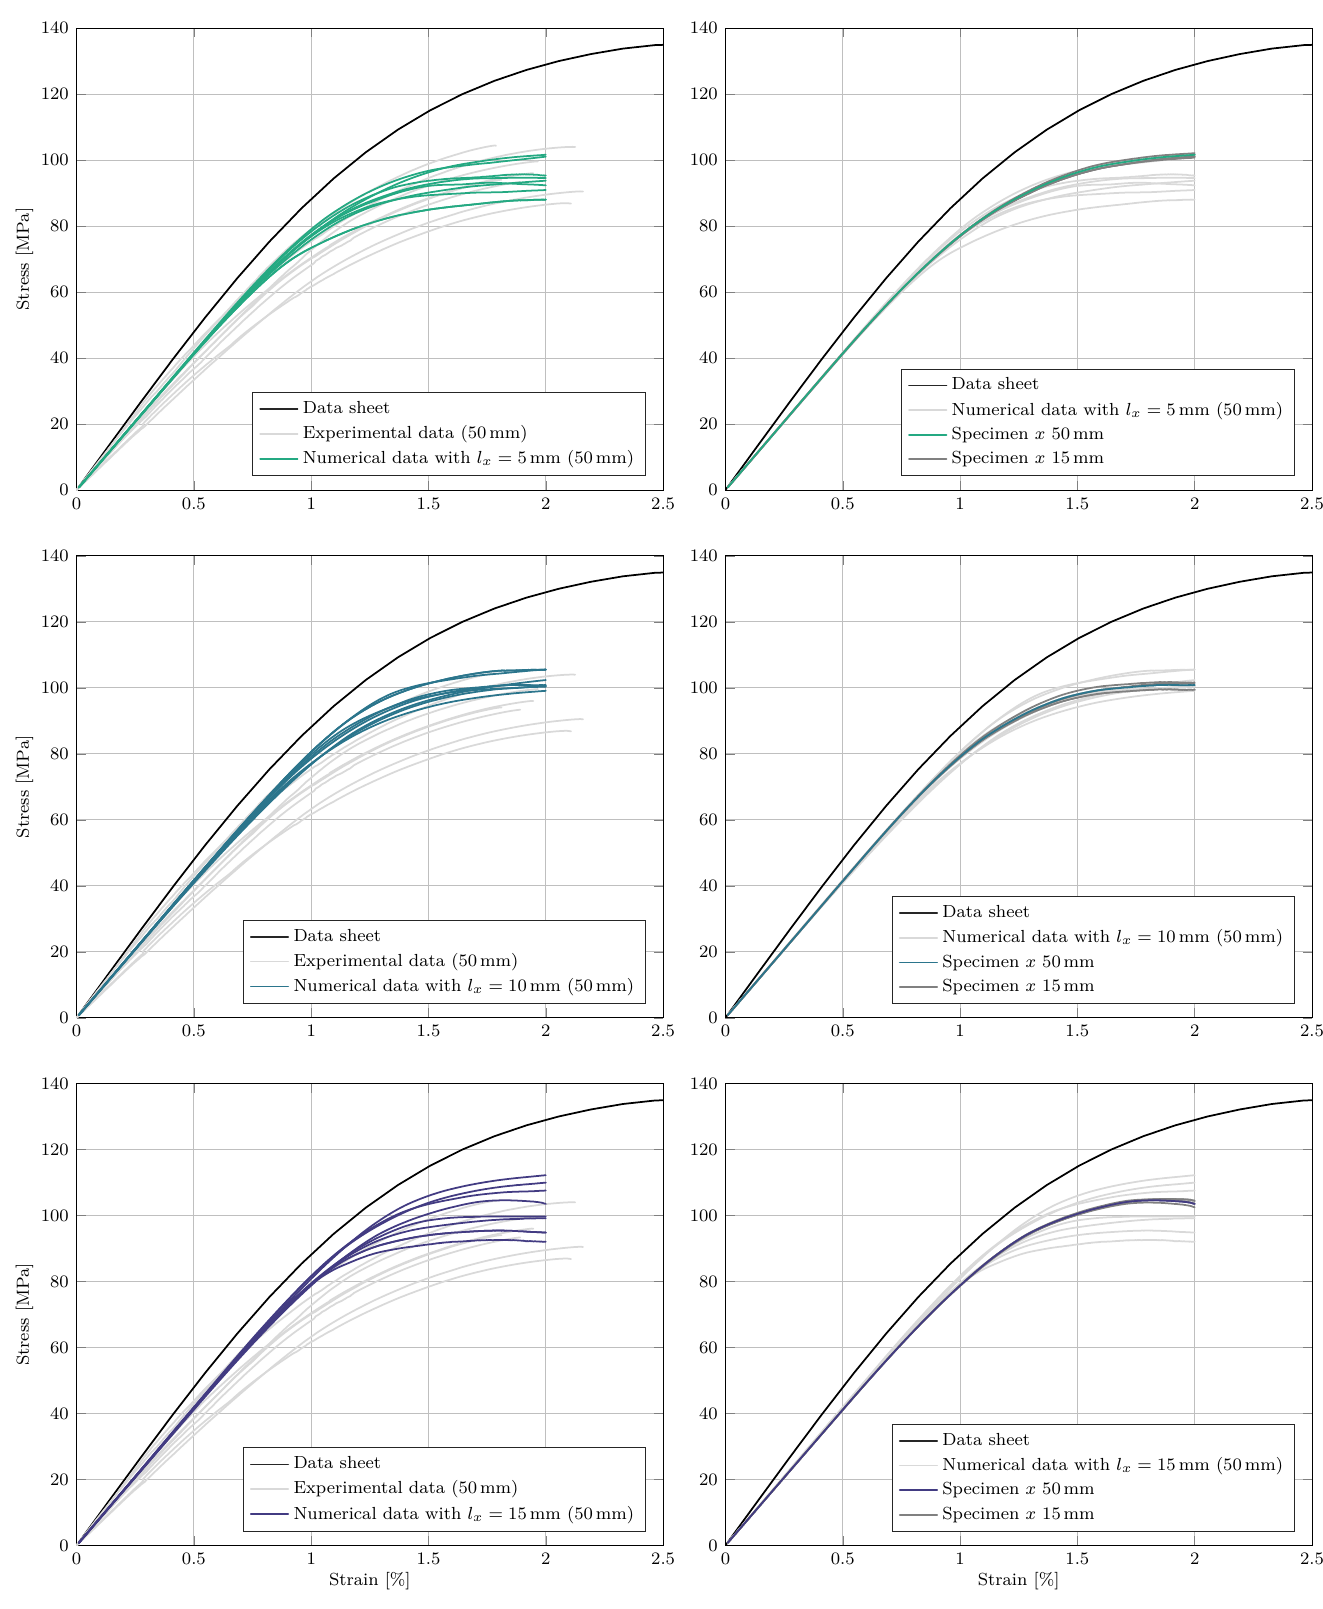
Figure 11. Results of the numerical simulation in comparison with the experimentally obtained results and a stress–strain curve provided by the manufacturer